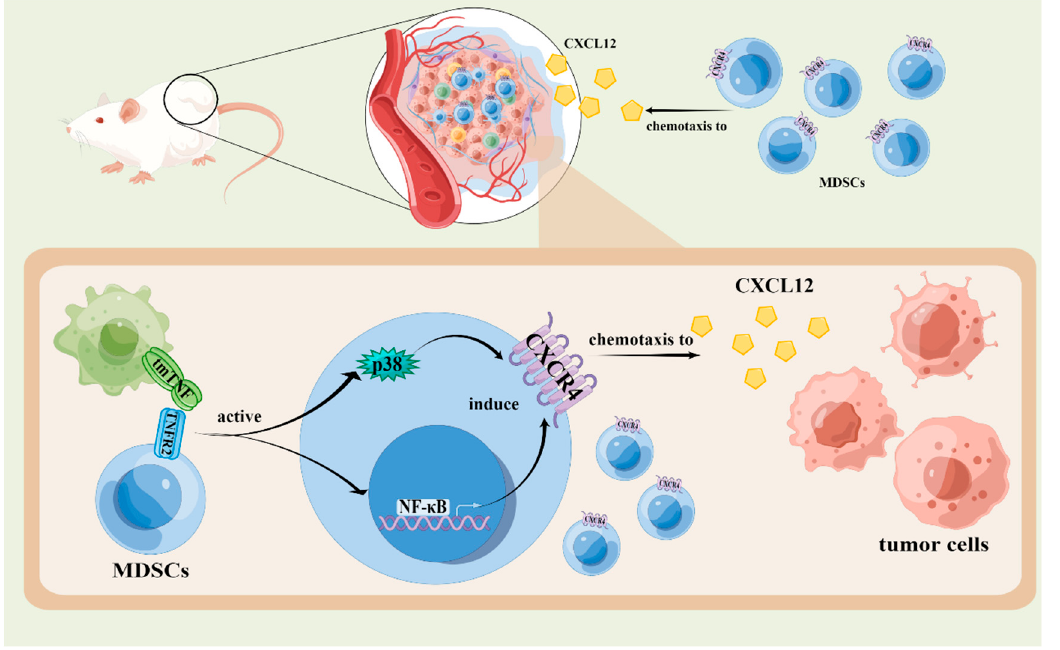
Figure 4. The effects of TNF signaling on the chemotaxis of MDSCs. The tmTNF activates NF- κ B and p38 signaling pathways in MDSCs mediated by TNFR2, inducing their expression of CXCR4, and subsequently enhancing the chemotaxis of MDSCs in tumor tissues secreting CXCL12. The figure was created using Figdraw (https://www.figdraw.com/ accessed on 19 August 2022).